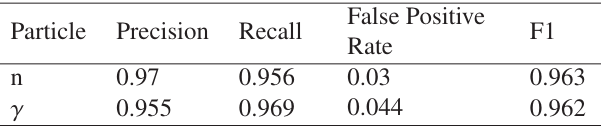
Table 2. Performance on neutral particles classification.